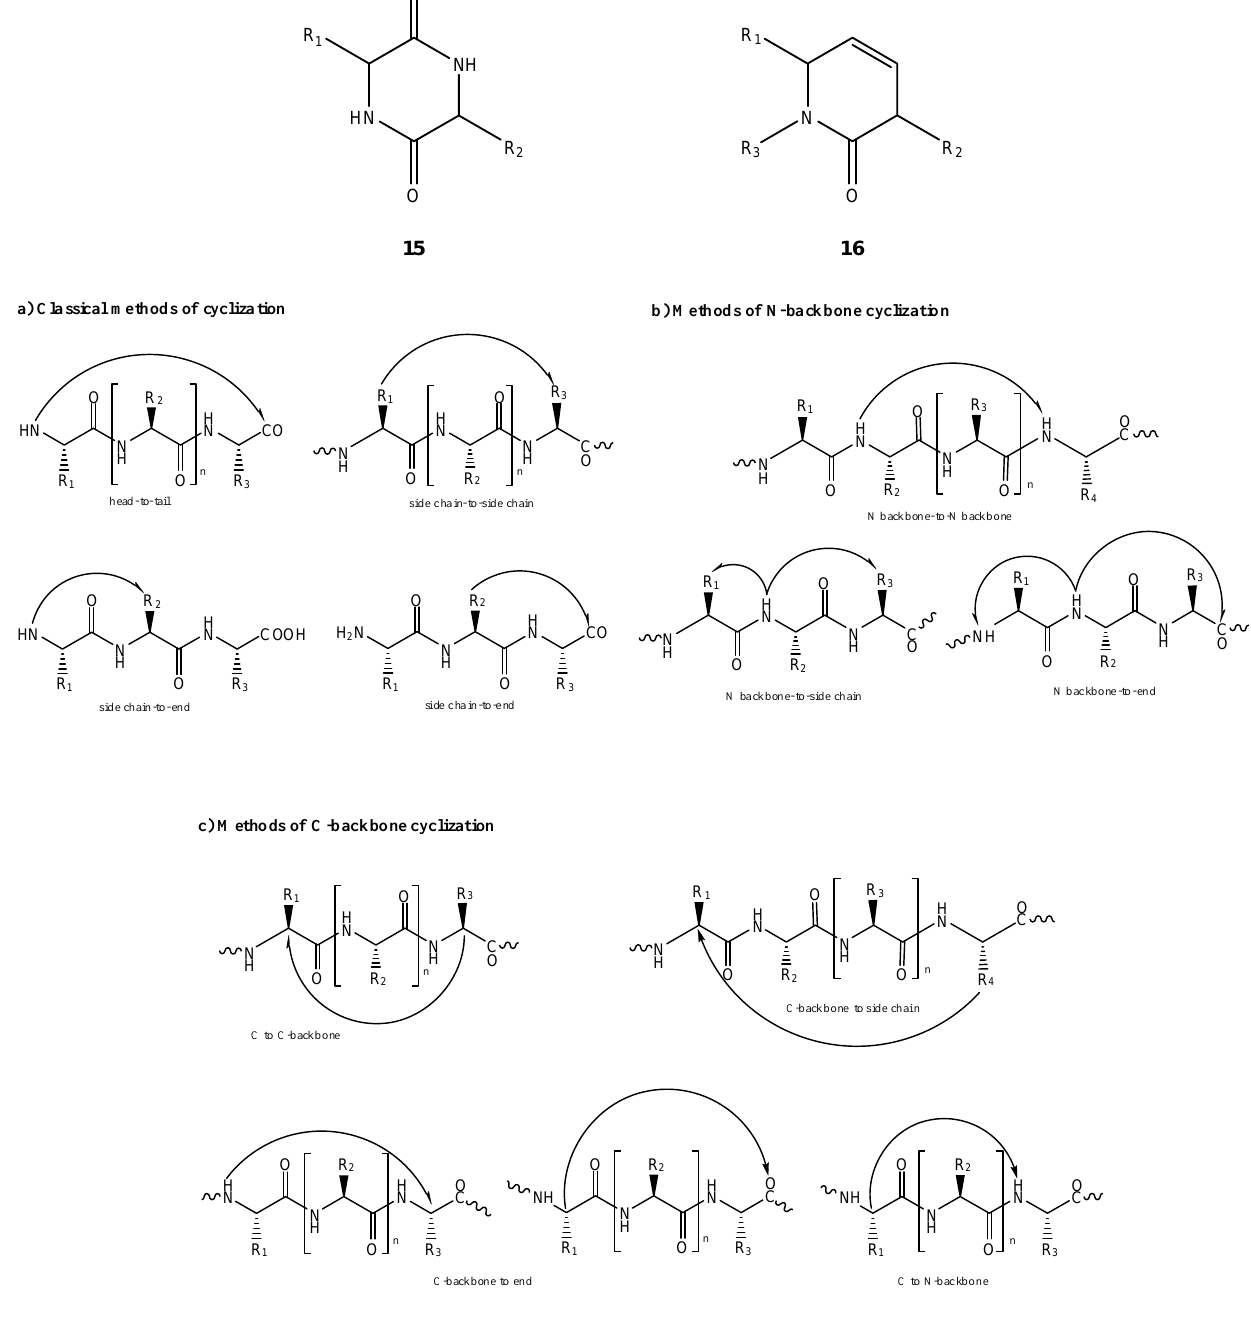
Figure 2. Routes for intramolecular peptide cyclization. Adapted from [31,